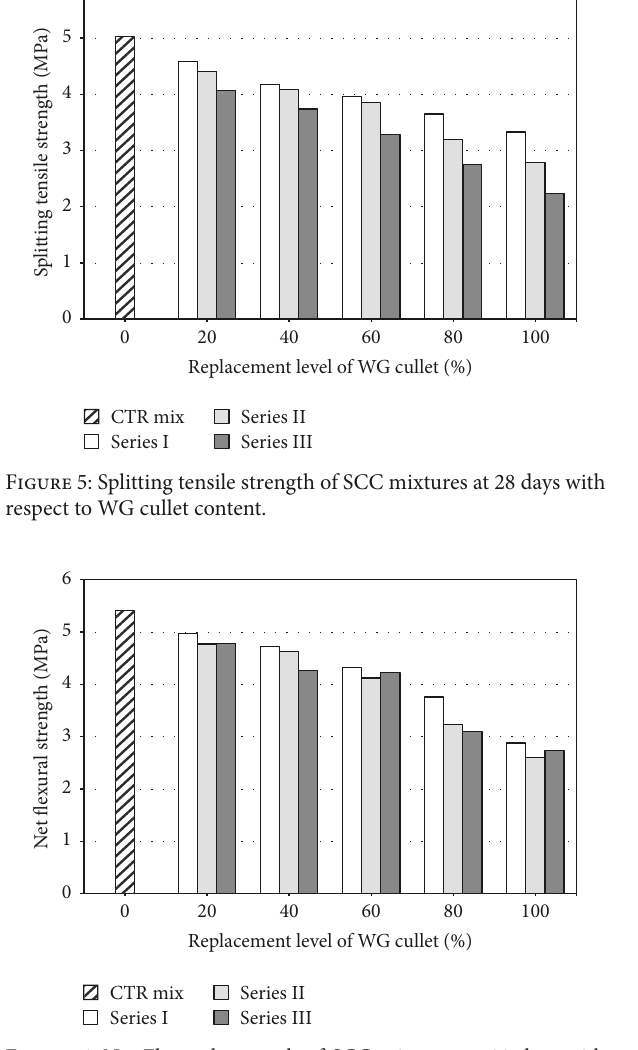
Figure 6: Net Flexural strength of SCC mixtures at 28 days with respect to WG cullet content.